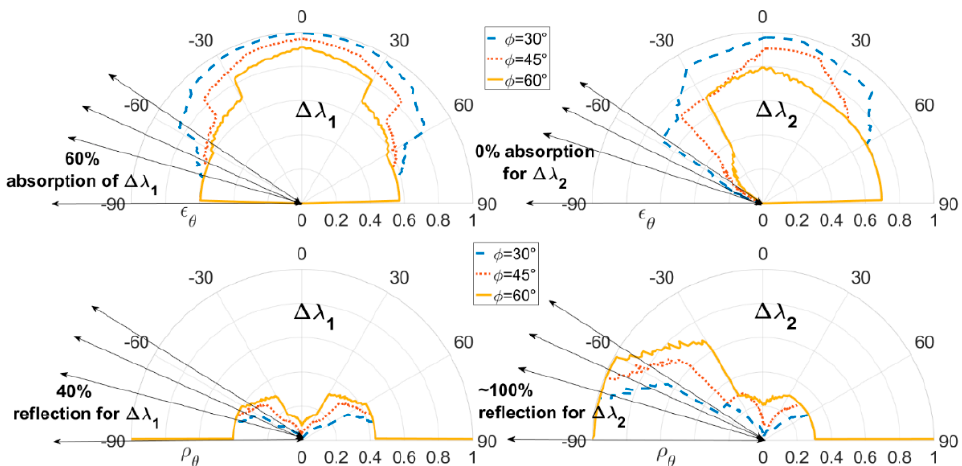
Figure 17. Polar diagrams for the distribution of directional emission and reflection from the sides a V-cavity composed of two different materials (Au and of a V-cavity composed of two different materials (Au and Si).